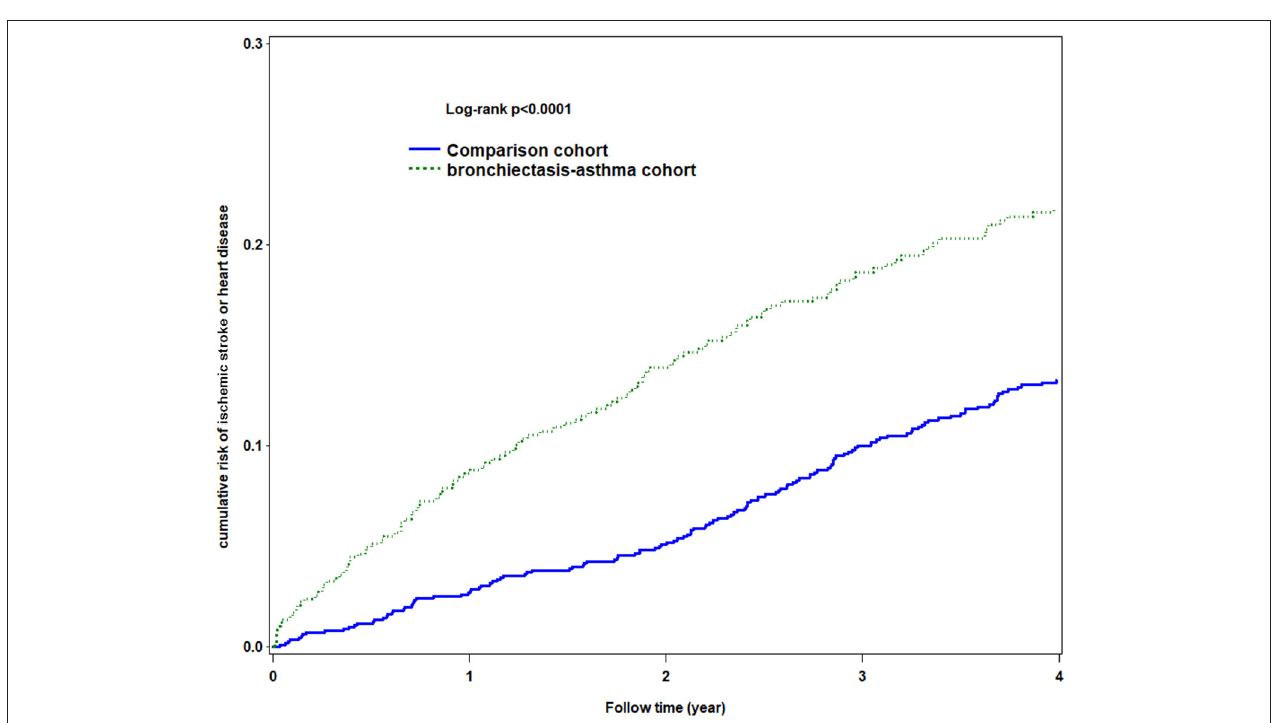
FIGURE 3 | Using Kaplan-Meier survival statistics, it showed crude overall survival curves by with and without bronchiectasis-asthma combination cohort (log-rank P < 0.0001).